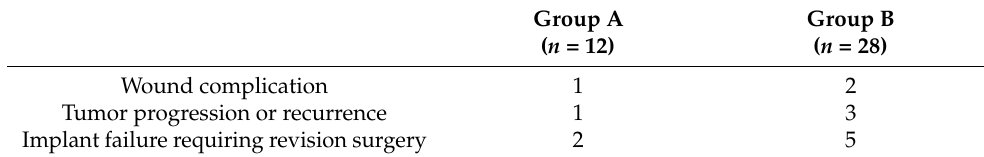
Table 2. Complications in groups A and